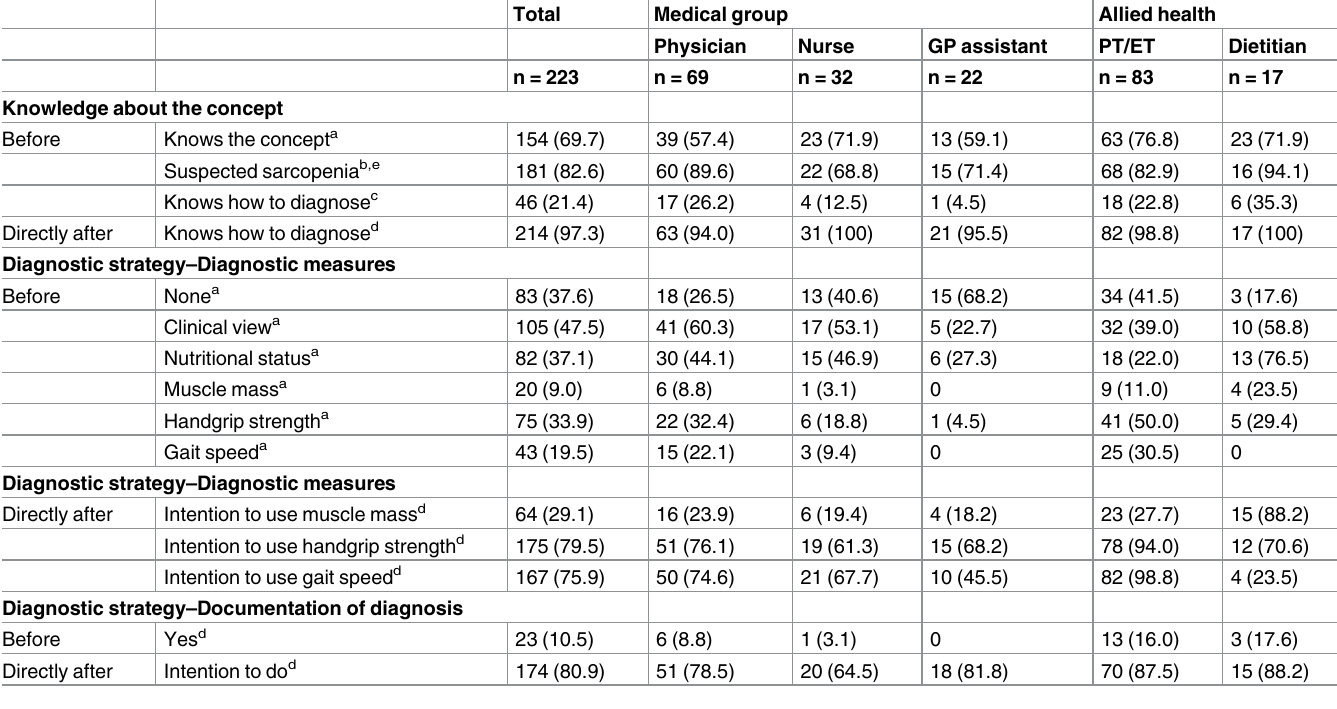
Table 2. Current state of knowledge about the concept of sarcopenia and diagnostic strategyof healthcare professionals before and directly after